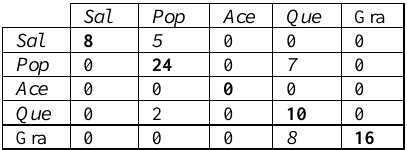
Table 9 . Confusion matrix obtained with RLR- ℓ1 on reduced